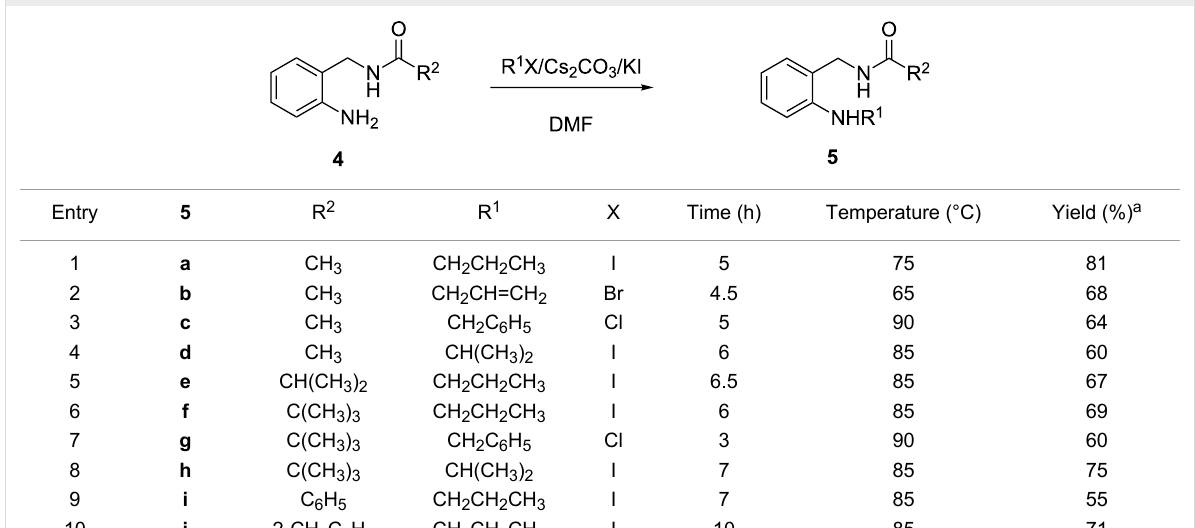
Table 2: Synthesis of compounds 5